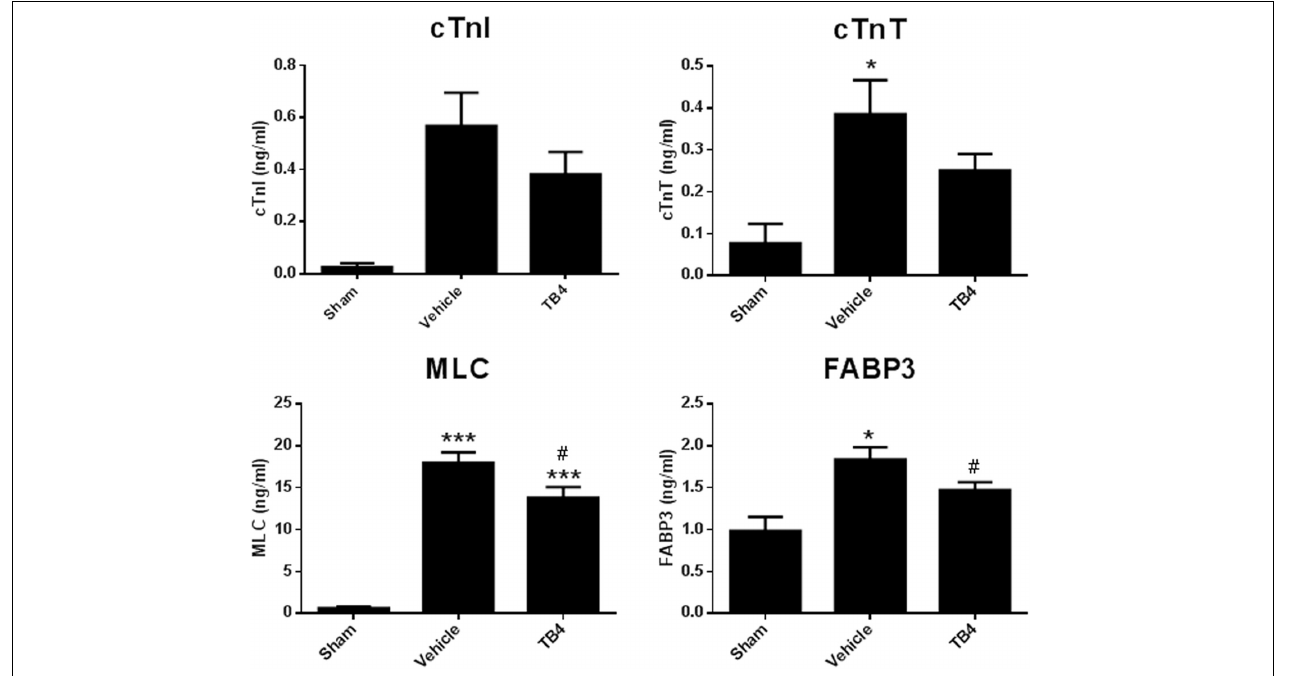
FIGURE 3 | Plasma levels of markers of myocyte damage 3 days post-MI surgery. Elevations in cTnI due to MI were highly variable and did not reach statistical significance. Elevation in cTnT due to MI was significant, but the trend toward reduction in the MI group treated with T β 4 was not. Elevation in MLC and FABP3 due to MI were significantly reduced in the T β 4 treatment groups. Note that at the 3 days time point, dosing regimens were identical